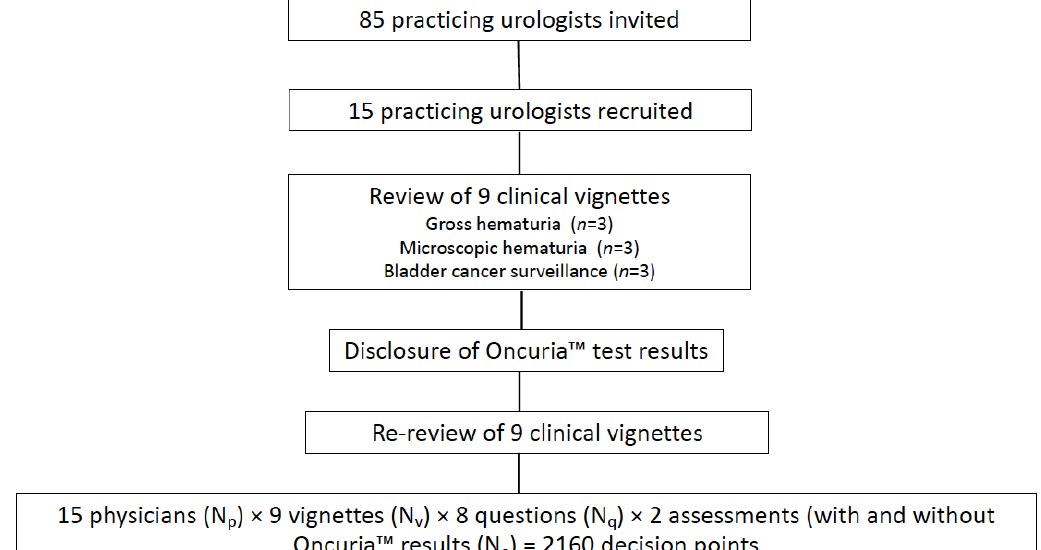
Figure 1. Study schema.